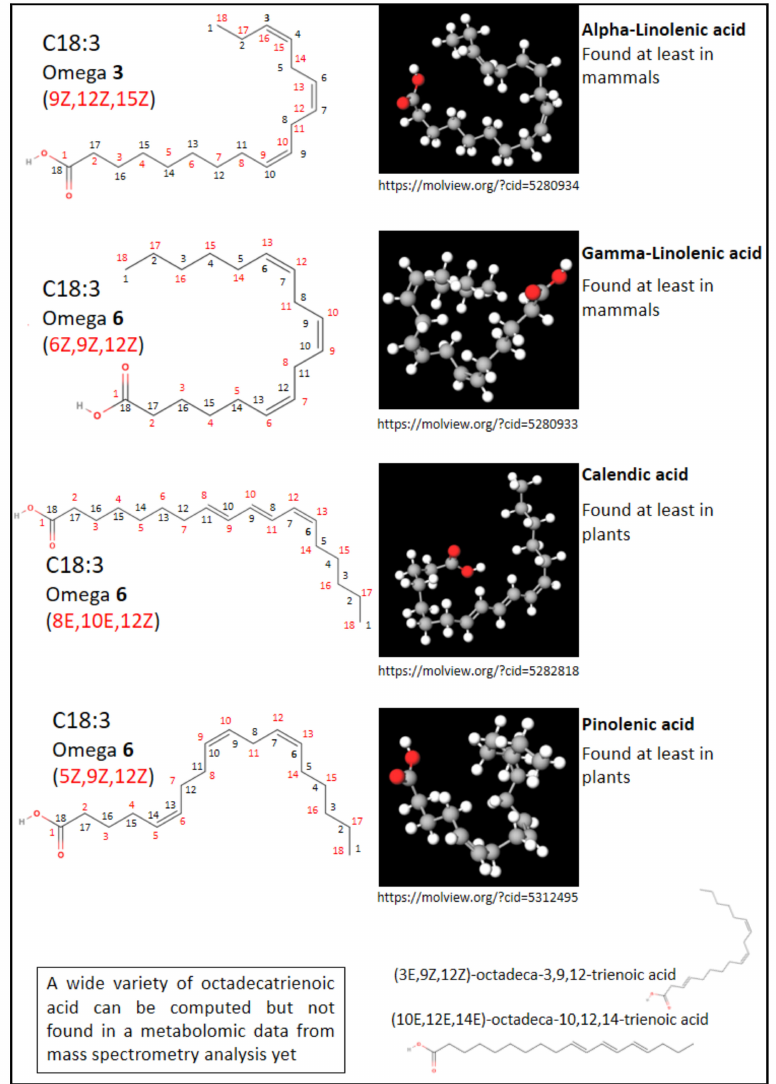
Figure 2. FA nomenclature. The chemical structure of FA showing the physiological numbering (black), the first double bond being at the third or sixth carbon from the omega start, and the chemical numbering (red) with conventions for the double bond location (E in cis, Z in trans). One of numerous possibilities of 3D representation was obtained thanks to Molview [11]. 3D structure is influenced by local environments such as